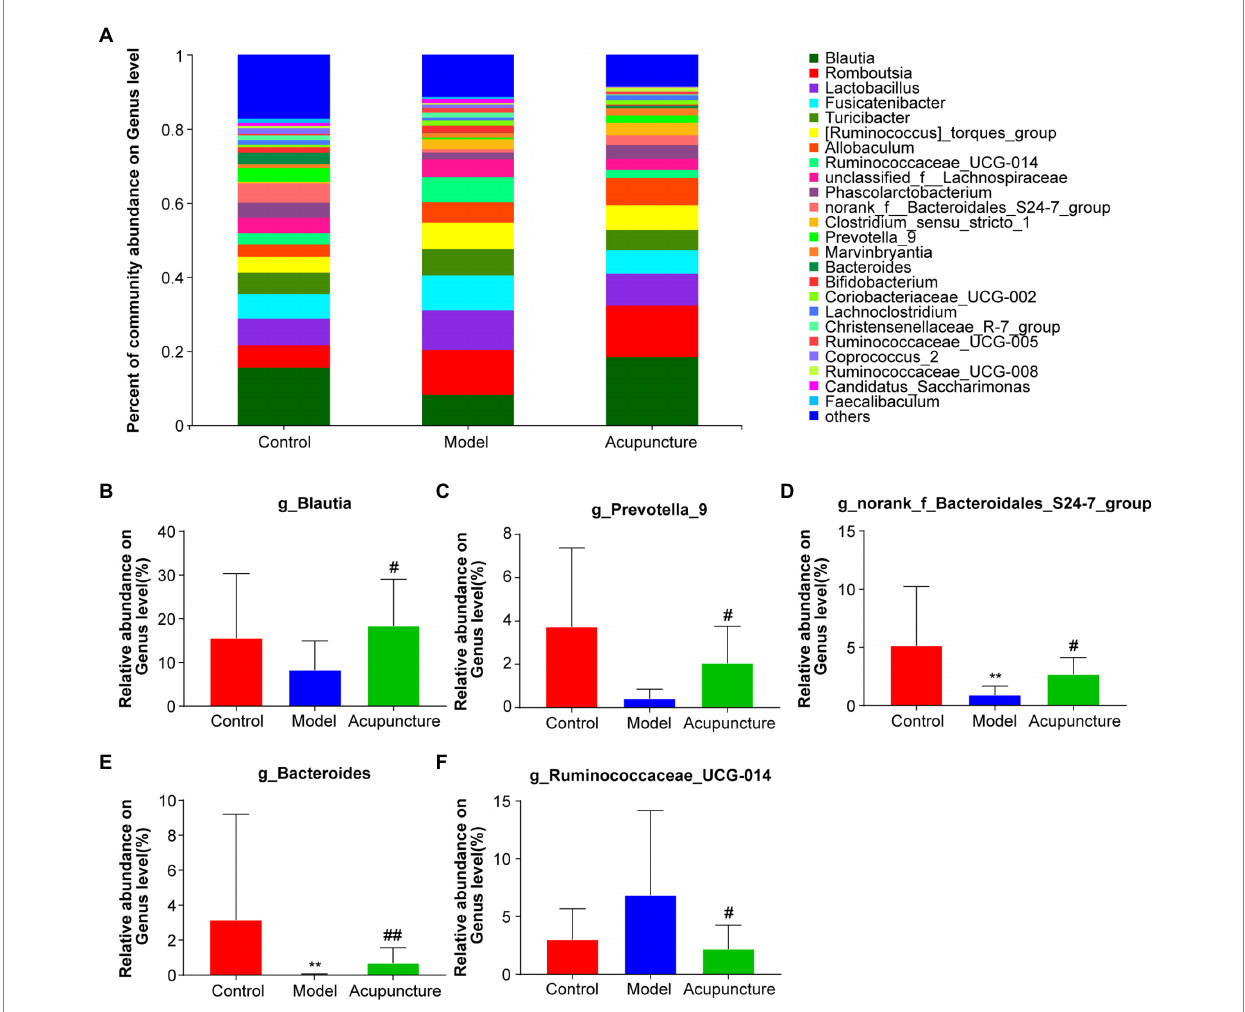
FIGURE 7 Modulation of intestinal microbiota composition by acupuncture at the genus level. (A) Community bar plot analysis of intestinal microbiota. (B) Blautia; (C) Prevotella_9. (D) norank_f_Bacteroidales_S24-7_group. (E) Bacteroides. (F) Ruminococcaceae_UCG-014. Data are shown as mean ± SD ( n = 8 per group). ** p < 0.01, Control vs. Model, # p < 0.05, ## p < 0.01, Model vs.